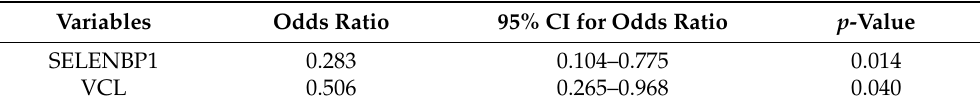
Table 5. Binary logistic regression analysis of serum SELENBP1 and VCL for diagnosis of CAS- induced sudden death. Odds ratio represents the risk change per 10-unit increase in markers. Variables Odds Ratio 95% CI for Odds Ratio p -Value SELENBP1 0.283